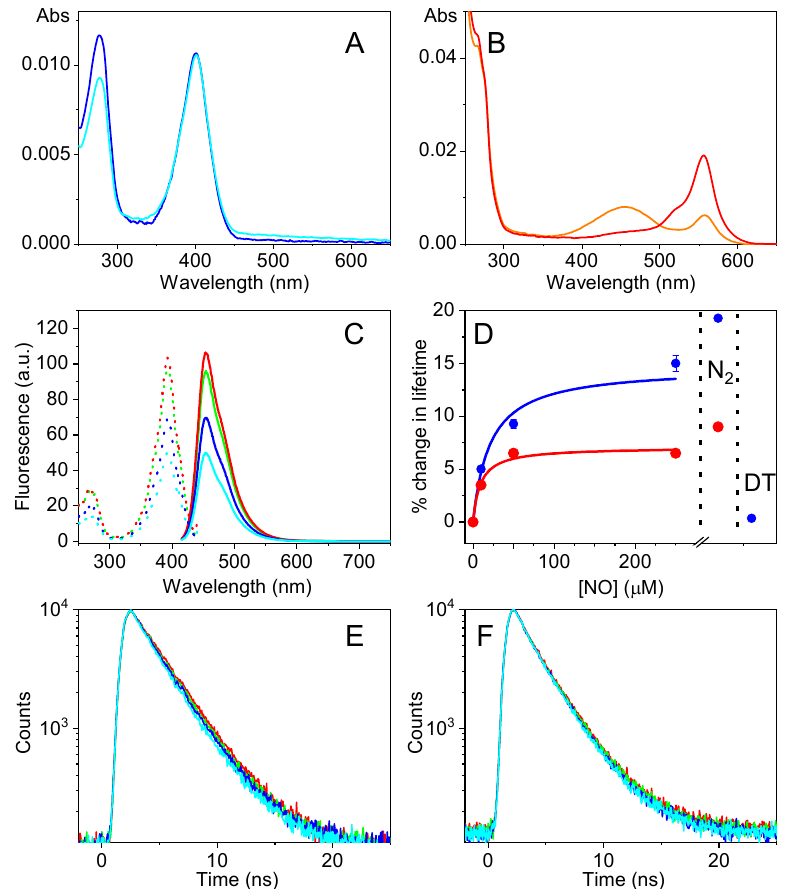
Figure 5. ( A ) Comparison between absorption spectra of mTagBFP2 at pH 7.4 (cyan) and pH 5 (blue). ( B ) Comparison between absorption spectra of TagRFP-T at pH 7.4 (red) and pH 5 (orange). Fluorescence excitation (dotted lines) and emission (solid lines) spectra ( C ) and fluorescence decays ( E ) of mTagBFP2 in acetate buffer at pH = 5 after deoxygenation with N 2 (red) and at different NO concentrations: [NO] = 10 µM (green), [NO] = 50 µM (blue), and [NO] = 250 µM (cyan). The sample was then exposed to N 2 flow for three hours (N 2 ) and subsequently reduced with Na dithionite (2 mM) to revert NO binding (DT). For emission spectra, λ ex = 400 nm, and for excitation spectra, λ em = 460 nm. Excitation for time-resolved fluorescence was at 380 nm, and detection was at 460 nm. ( F ) The fluorescence decays for TagRFP-T in acetate buffer at pH = 5. The color code was the same as for ( E ). Excitation was at 500 nm, and detection at 585 nm. ( D ) The percent change in average life- times for TagRFP-T (red circles) and mTagBFP2 (blue circles). The solid lines are the results of the fits of the lifetime data with a model for binding of NO to the protein.